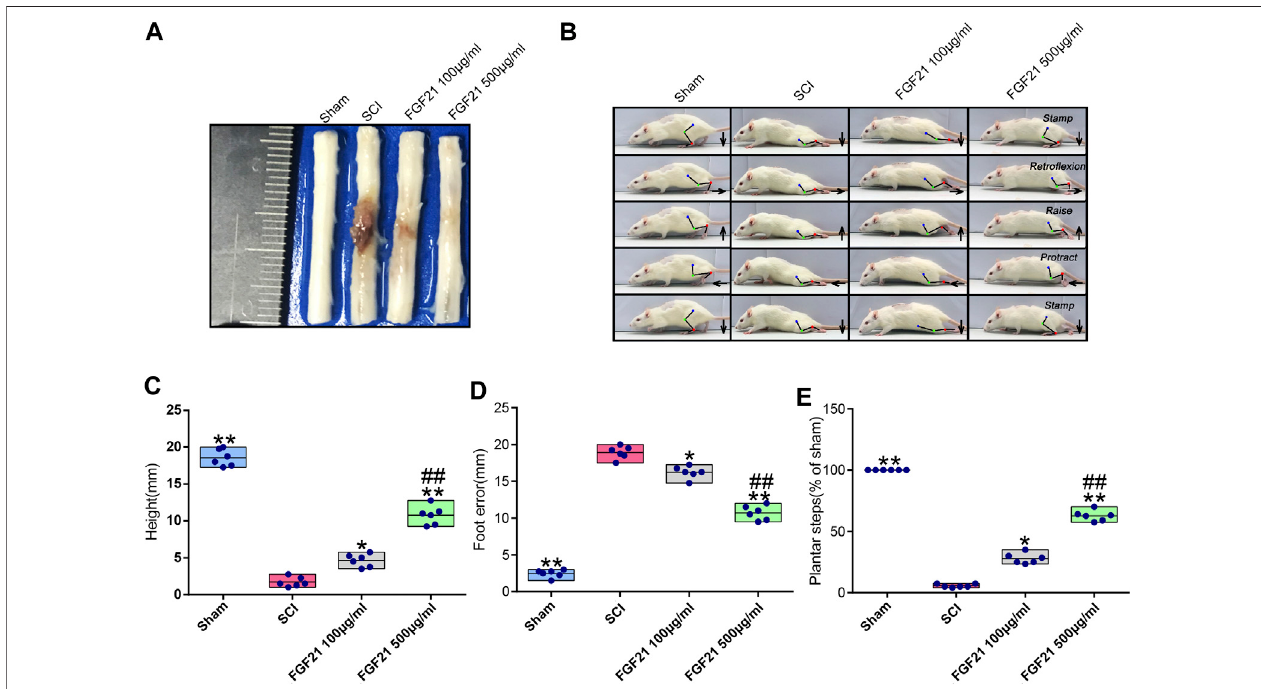
FIGURE 1 | FGF21 treatment improves the recovery of spinal cord appearance and hindlimb function (A) Image to show different appearance of spinal cords in every group (B) Motional sequence of rats in every group. The blue, green and red dot marks represent Hip (iliac crest), knee and ankle joints; respectively. And they are connectedbylines.Arrowdisplaysthedirectionsinwhichfeetmovement (C – E) Statisticalgraphsofheightoftrunkabovetheground,foot-placementerrorandnumber ofsuccessfulplantarsteps.Representationofdataismeanvalues ± SEM, n (cid:1) 6, “ * ” and “ ** ” represent p < 0.05or p < 0.01vstheSCIgroup, “ ## ” represent p < 0.01 vs the 100 μ g/ml FGF21 group.